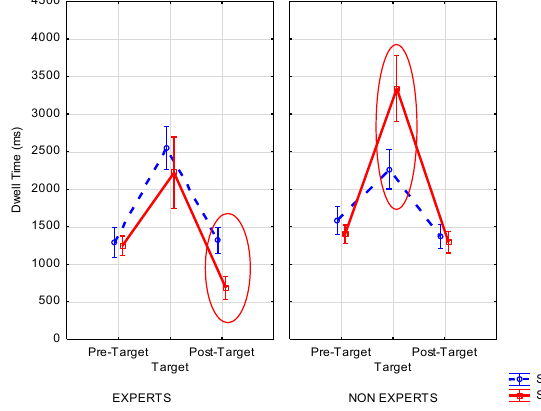
Figure 9. Dwell time (ms) for the pre-target, target and post- target AOIs according to expertise and presentation (error bars represent standard